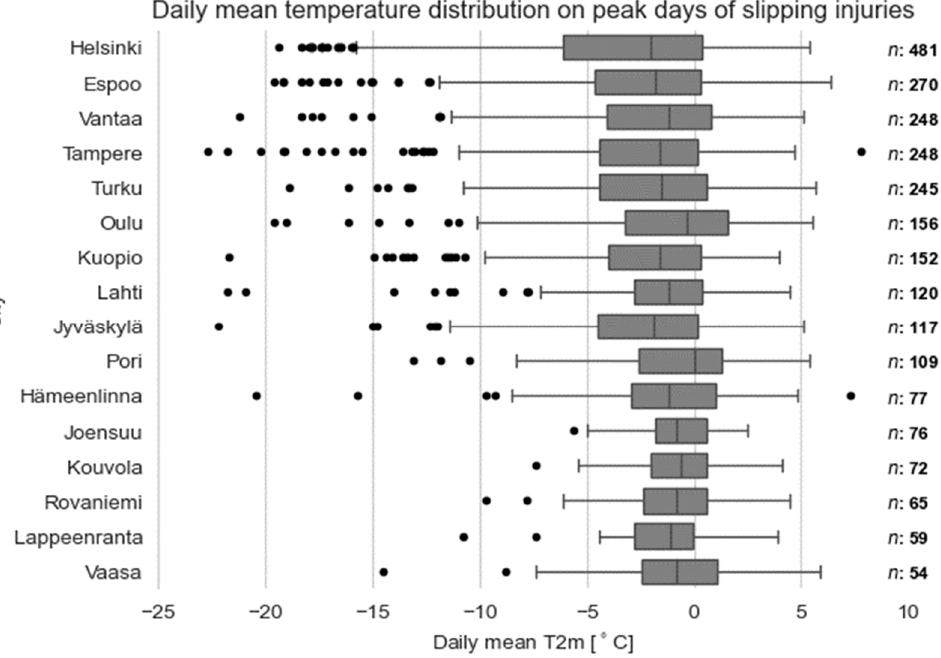
Figure 5. Box plot for daily mean temperature on peak days in different cities during the 14 winters between the years 2005 and 2019. Boxes correspond to upper and lower quartiles of the data, with the vertical line in each box showing the median. Whiskers indicate variability outside the quartiles and outliers are shown as individual black points. The number of peak days ( n ) for each city is shown on the right.